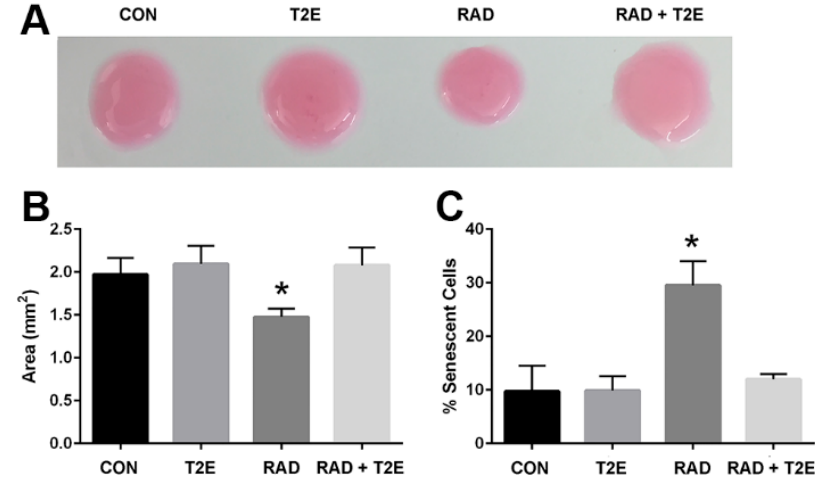
Figure 4. MnTE-2-PyP prevents radiation-induced activation and senescence of mouse primary fibroblasts ex vivo. ( A ). Fibroblasts were obtained from mice treated with +/ − MnTE-2-PyP and +/ − radiation, at 2 months post-radiation and cultured for two weeks. The cells were then embedded in rat collagen discs for 6 h and then the collagen discs were measured and the area calculated by ImageJ. ( B ). The average area of the collagen discs was plotted for each group. A 1-way ANOVA followed by post hoc Tukey’s test for multiple comparisons was used to determine differences between the disc sizes. ( C ). After 3 weeks of culture, the cells were stained for SA- β -gal activity. The number of SA- β -gal expressing cells were quantified by ImageJ by using inverted brightfield images. Differences of average percentage of senescent cells were analyzed using a 1-way ANOVA followed by a post hoc Tukey’s test for multiple comparisons. The symbol (*) denotes a significant difference as compared to the control group. The collagen contraction assays and SA- β -gal staining assays are representative of 10 mice/group.